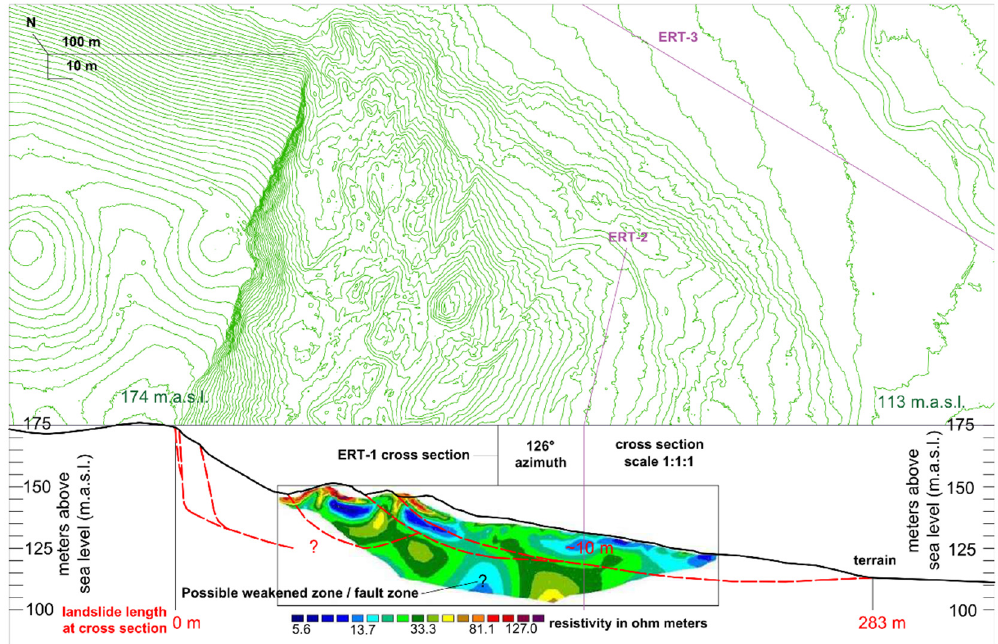
Figure 10. Hrvatska Kostajnica landslide cross section (parallel to movement) and interpreted ERT-1 data. At cross section area the length of the landslide is 283 m with multiple slide surfaces. The depth of the interpreted sliding surfaces varies from ~20–30 m at head scarp area, to ~10–20 m at landslide body area and ~1–10 m at landslide toe part area. In the middle part of the cross section possible fault zone is present (marked with question mark). The contour line interval on the topographical map is 1 m.